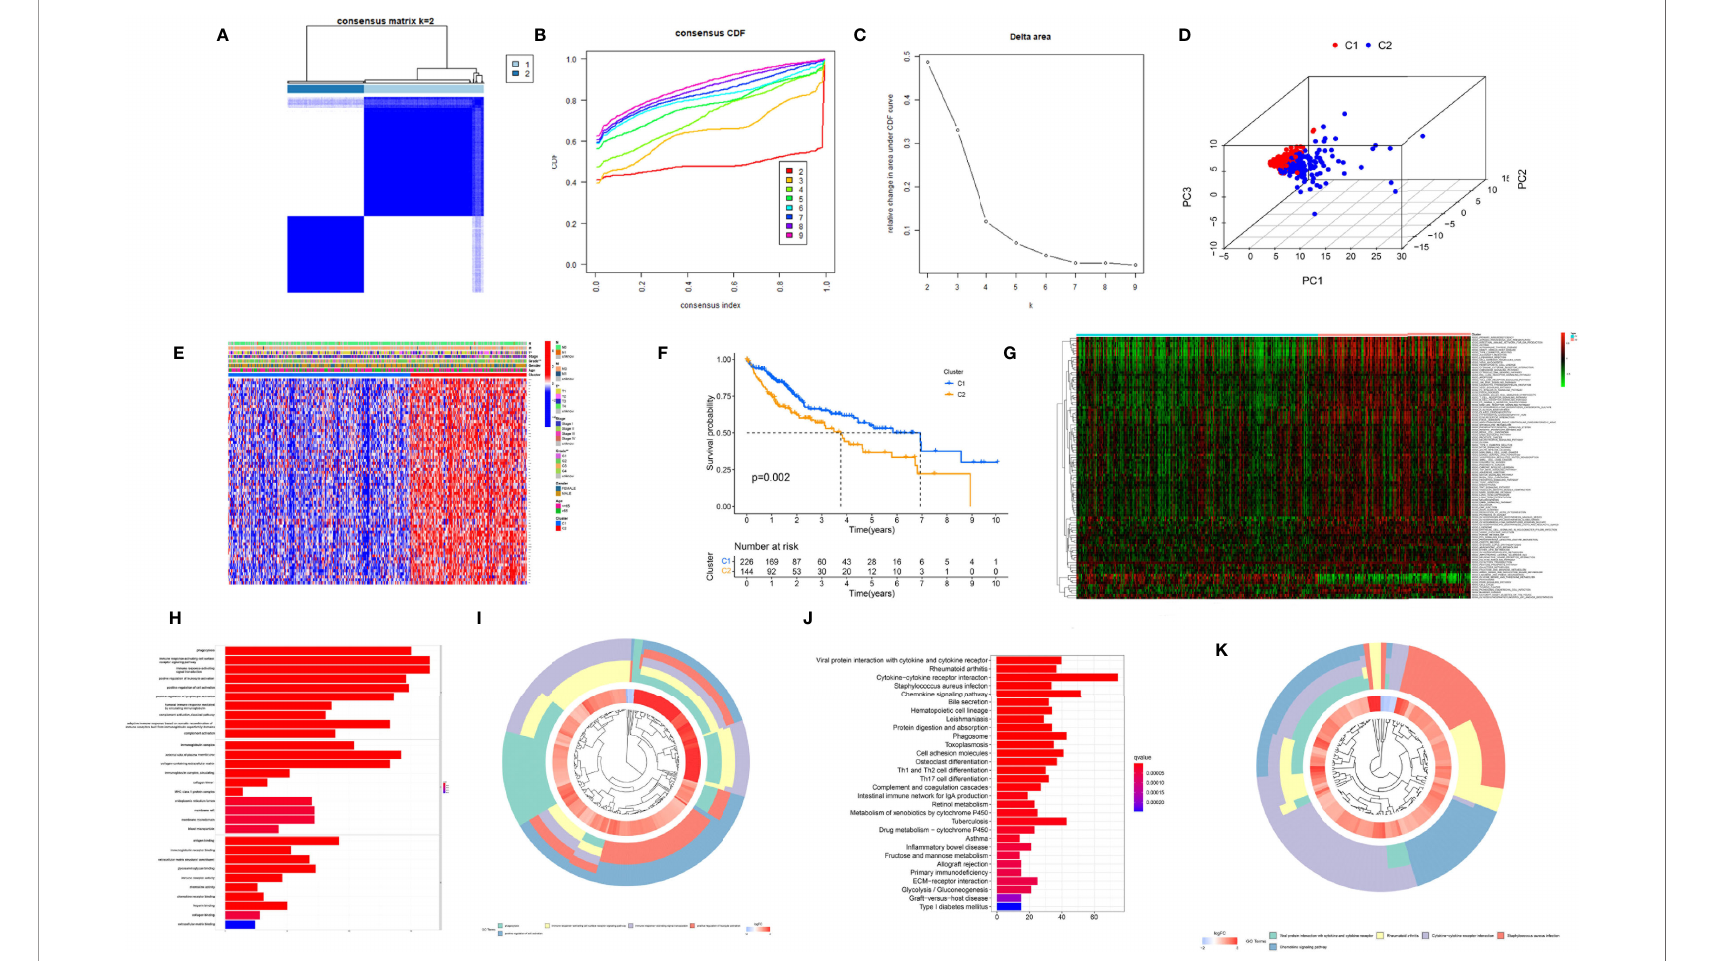
FIGURE 3 | Cluster analysis of intersection genes related to macrophages in the TCGA cohort. (A) The LIHC dataset in the TCGA cohort was divided into two distinct clusters when k = 2. (B) Consensus clustering cumulative distribution function (CDF) for k = 2 to 9. (C) Relative change in the area under the CDF curve for k = 2 to 9. (D) The 3D PCA plots showed the cluster could distinguish hepatocellular carcinoma (HCC) patients based on the expression pro fi les of the LIHC dataset. (E) Heatmap of distribution of clinicopathological variables between different cluster groups. (F) The Kaplan – Meier curve survival analysis between different cluster groups. (G) The heatmap displaying the biological processes in distinct macrophage-related clusters analyzed by gene set variation analysis. (H) The bar plot and (I) the cluster plot of the GO pathways of enriched differentially expressed genes between different cluster groups. (J) The bar plot and (K) the cluster plot of the KEGG pathways of enriched differentially expressed genes between different cluster groups. * P < 0.05; ** P <